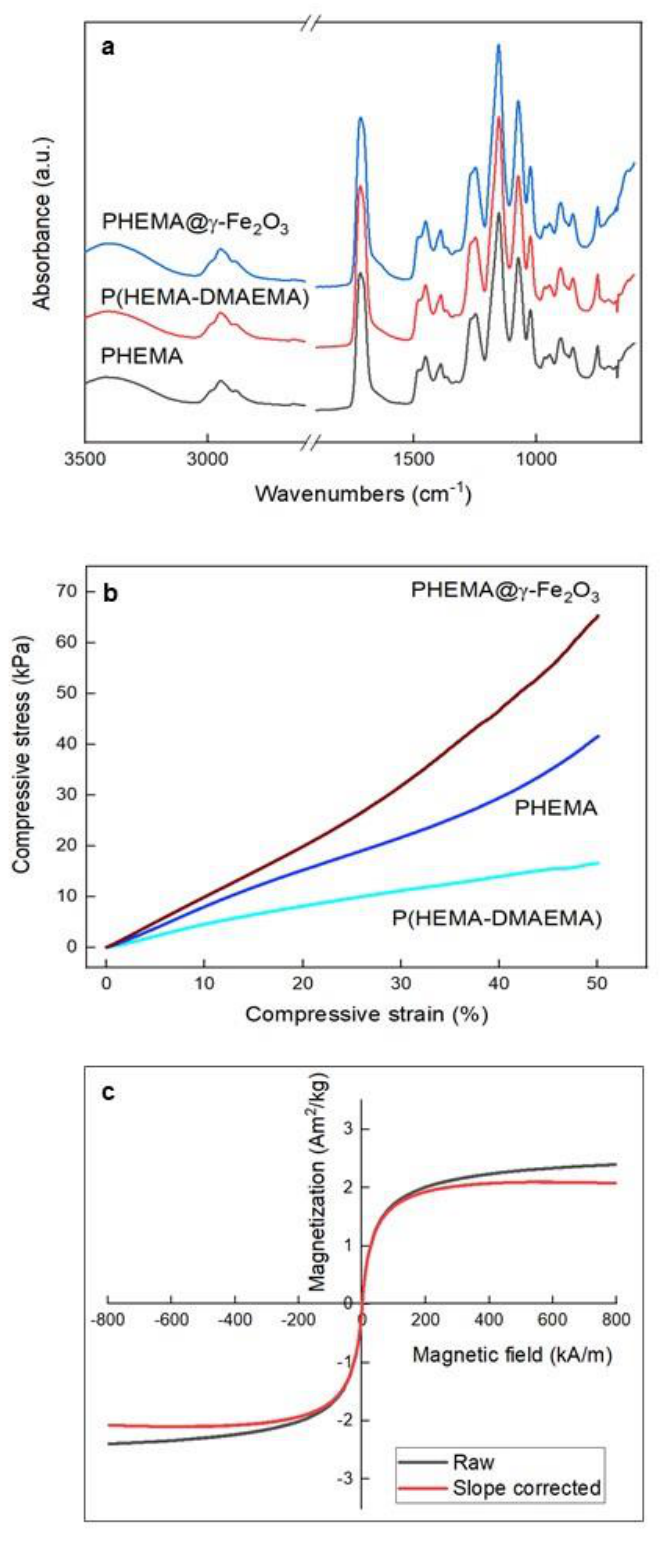
Figure 4. ( a ) FTIR spectra and ( b ) dependence of compressive stress of PHEMA, P(HEMA- DMAEMA), and PHEMA@ γ -Fe 2 O 3 hydrogels on strain, and ( c ) magnetic hysteresis loop of PHEMA@ γ -Fe 2 O 3 hydrogel both before and after correction for linear paramagnetic slope.